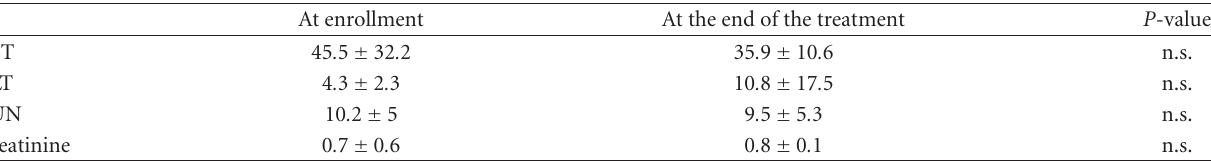
Table 2: Comparison of the liver aminotransferase and renal function before and at the end of fosfluconazole prophylaxis. At